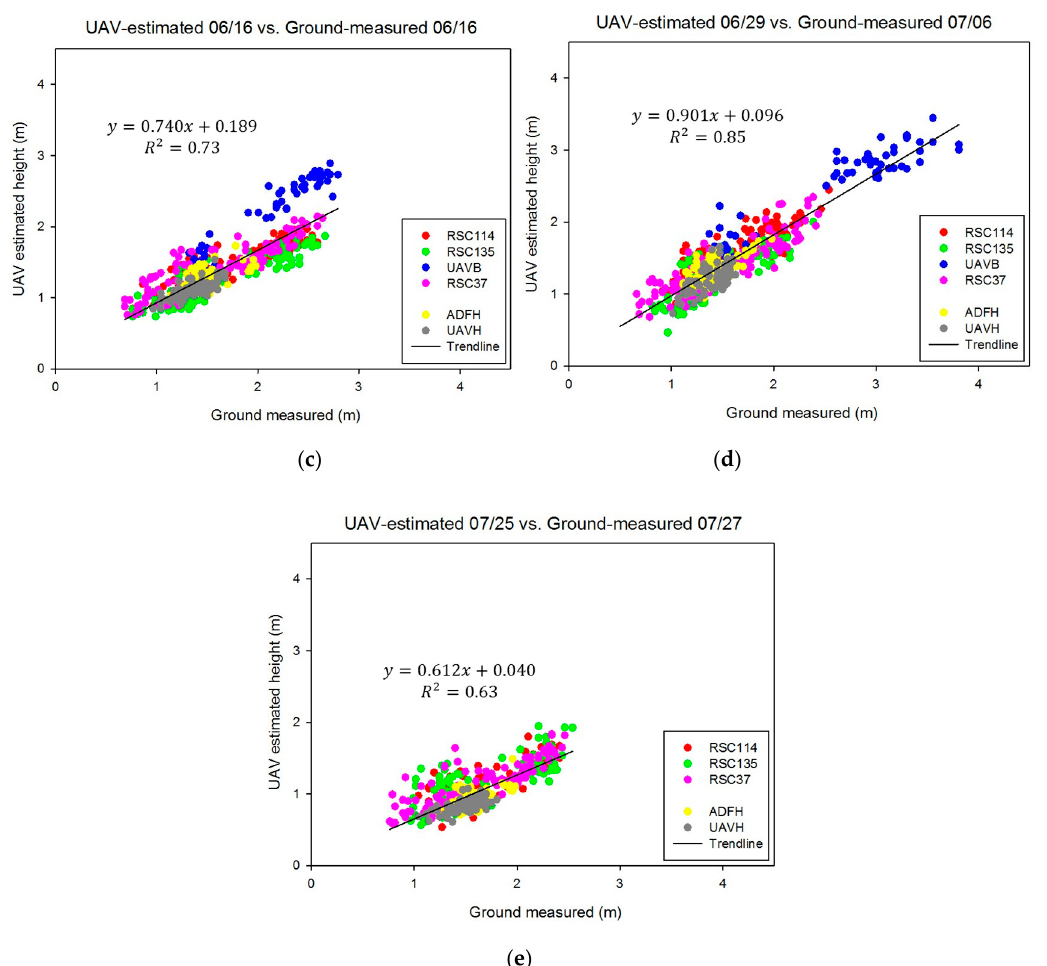
Figure 14. Correlations between UAV-estimated plant height and ground-truth plant height for all experimental tests over five flights on ( a ) 05/24, ( b ) 05/30, ( c ) 06/16, ( d ) 06/29, and ( e ) 07/25.